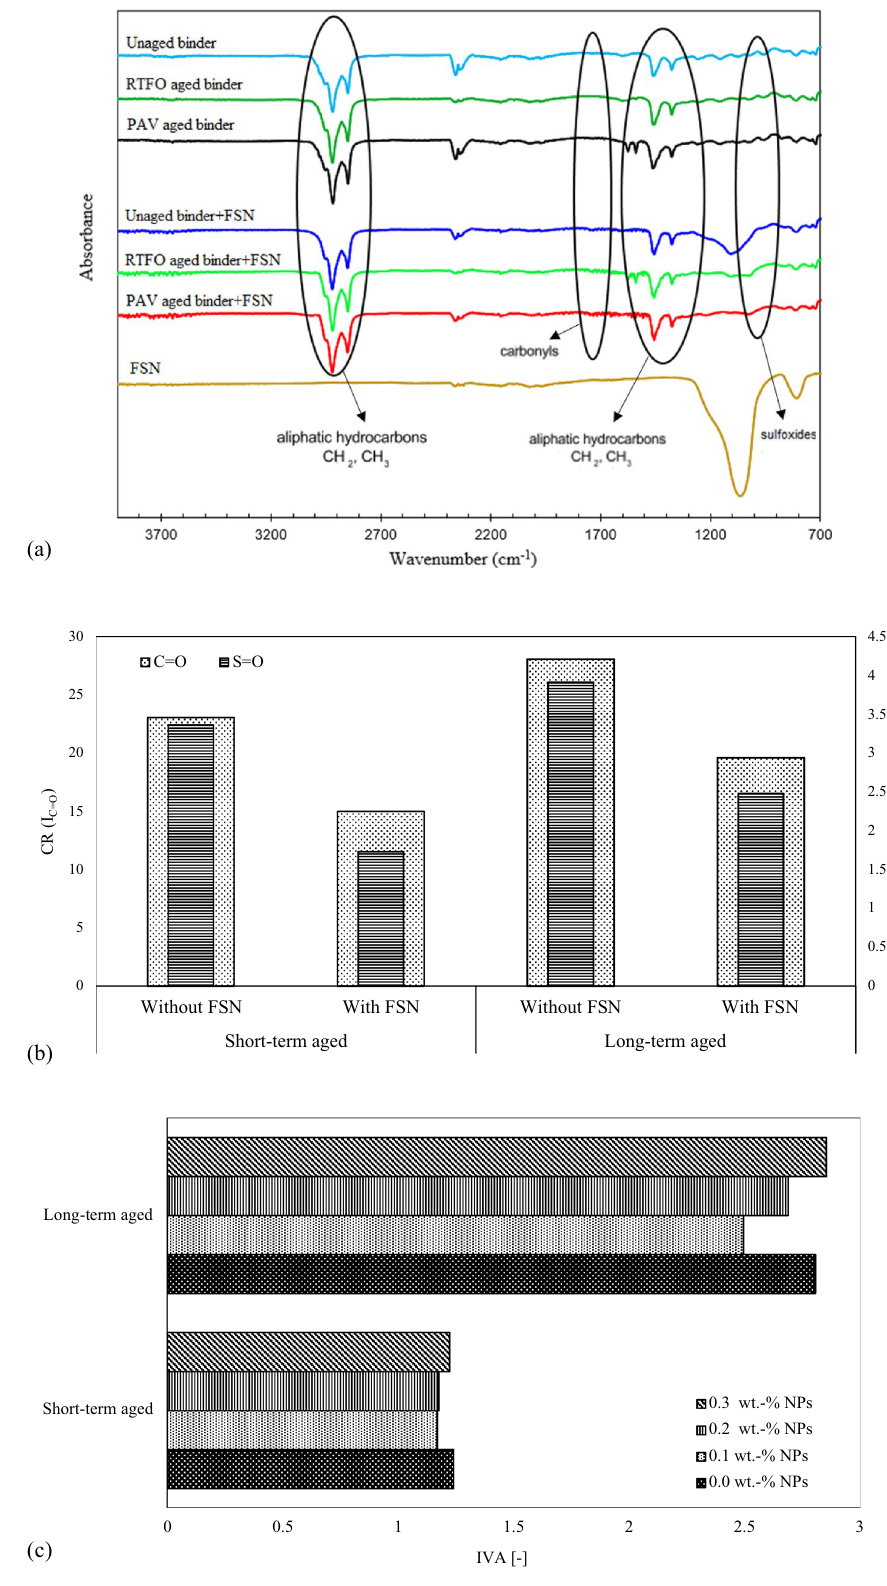
Figure 7. ( a ) Fourier Transform Infrared Spectroscopy (FTIR) spectra of the binder samples in the wavenumber range from 700 to 4000 cm 1 for different aging conditions. ( b ) Aging indexes based on carbonyl and sulfoxide groups at different aging conditions. ( c ) Index of viscosity aging (IVA) of control and modified